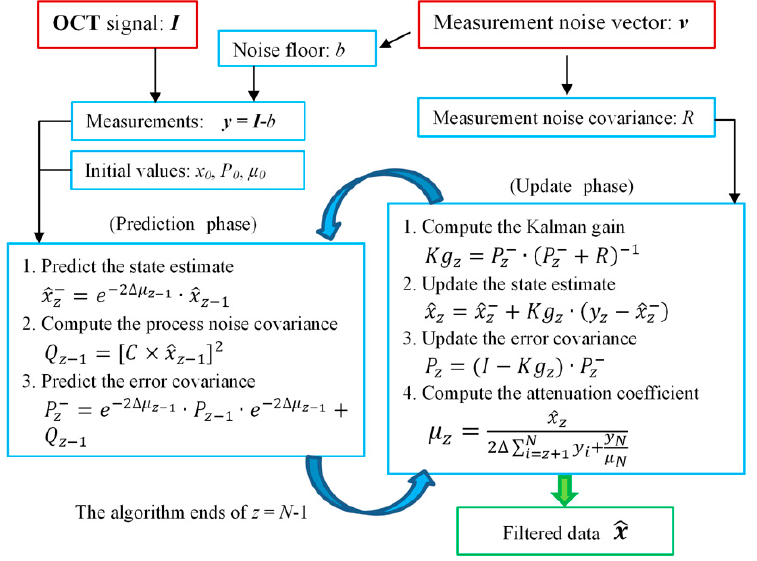
Figure 3. The entire algorithm process of the Kalman filter applied to the OCT signals. In Figure 3, the red boxes are the inputs, the green box is the output, and the blue boxes are the process variables. I is the original OCT signal. v is the noise vector obtained by recording the reference arm spectrum. b is the mean of the noise vectors. y is the OCT signal after subtracting b . The initial value x 0 = y 0 , µ 0 can be calculated using Formula (2). The initial value P 0 is set to 1. P 0 has little effect on the result. In general, it cannot be set to to the output ˆ x